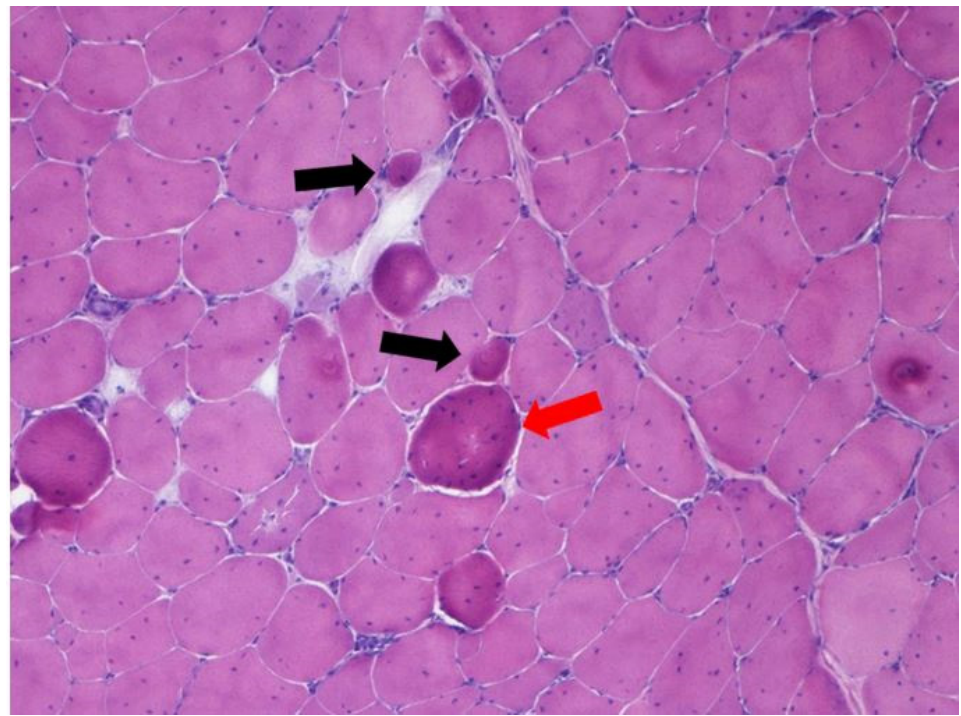
Figure 7. Ross 308 Pectoralis major . Presence of hypercontracted atrophic fibers ( black arrows ) and giant fiber ( red arrow ). H-E, 200×.